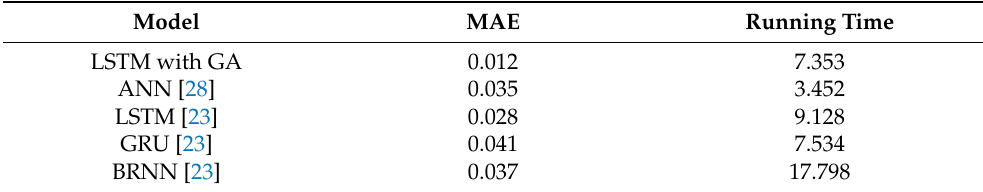
Table 6. Performance comparison between the proposed LSTM model with GA and ANN, LSTM, GRU, and BRNN. Model MAE Running Time LSTM with GA